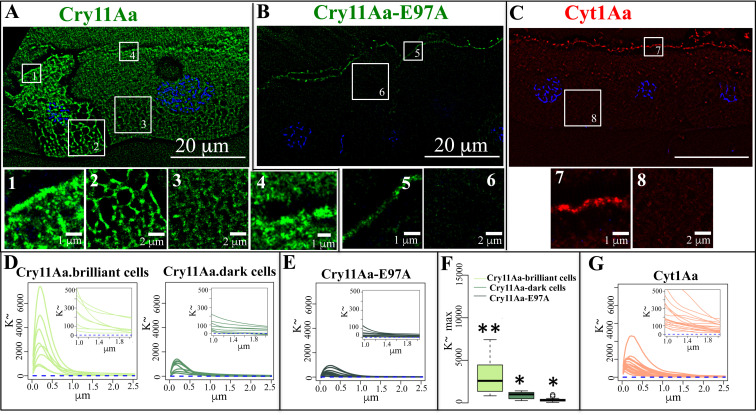
High resolution SRRF analysis showing the in vivo nanoscale localization of the labeled Cry11Aa-Alexa546 (Panel A), mutant Cry11AaE97A-Alexa546 (Panel B) and Cyt1Aa-Alexa647 (Panel C), in the midgut tissue of Aedes aegypti larvae. Cry11Aa proteins were labeled with Alexa546 showing green fluorescence. Individuals were fed with 1000 ng/ml of each labeled crystal inclusions proteins for 6 h. Next, larvae were processed, nucleus were stained with DAPI (blue fluorescence) and 100 frames of raw spinning disk data were recorded with the confocal Yokogawa spinning disk microscope alternating the laser lines illumination (405, 561 and 640 nm) per-frame basis, and Images were analyzed using NanoJ-core and NanoJ-SRRF plugins of Fiji-Image J software as described in Materials and methods. Panel A, shows one brilliant and one dark cell after Cry11Aa-Alexa546 ingestion. Insets show selected images to improve clarity of the images. Panel D, shows the Ripley’s K-function statistical image analysis of the xy pattern organization observed in selected 10 x 10 μm squares selected from different cells of larvae intoxicated with Cry11Aa-Alexa546. Inset, shows an enlargement of the distal organization. The Cry11Aa-brilliant cells, and Cry11Aa-dark cells were analyzed. Similar analyses were performed for different cells of larvae intoxicated with Cry11AaE97A-Alexa546 (Panel E) or Cyt1Aa-Alexa647 (Panel G). These Ripley’s K-function statistical image analysis compute the average number of particles located within a predefined radius of any typical event, normalized for the event intensity (density). Panel F, shows the Kruskal-Wallis test performed to the distributions with Cry11Aa-Alexa546 or Cry11AaE97A-Alexa546. Different asterisks indicate significant different data (P value = 0.05).